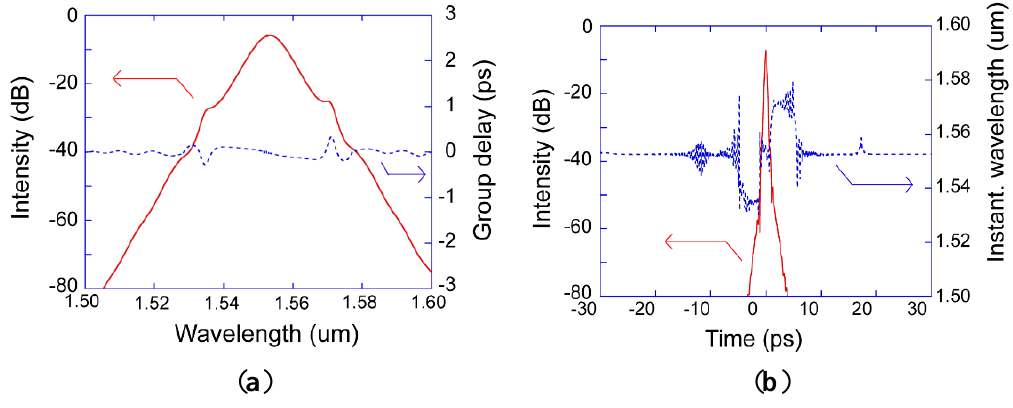
Figure 5. ( a ) Spectral and ( b ) temporal shapes of output pulses on log scale when a wavelength filter was used to remove the Kelly sideband components.